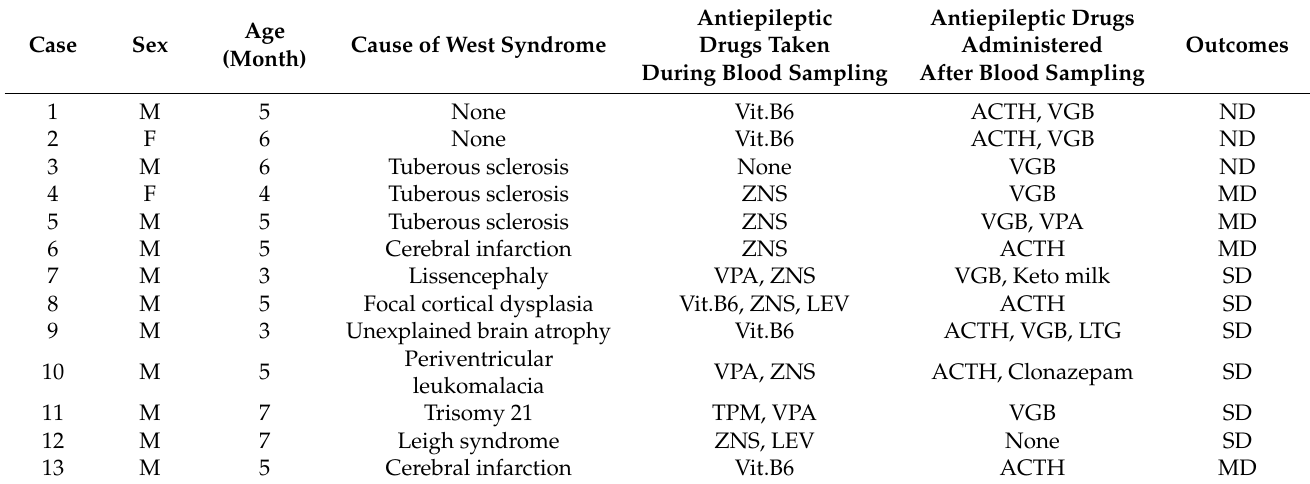
Table 1. Clinical features and diagnosis of pediatric patients with West syndrome ( n =